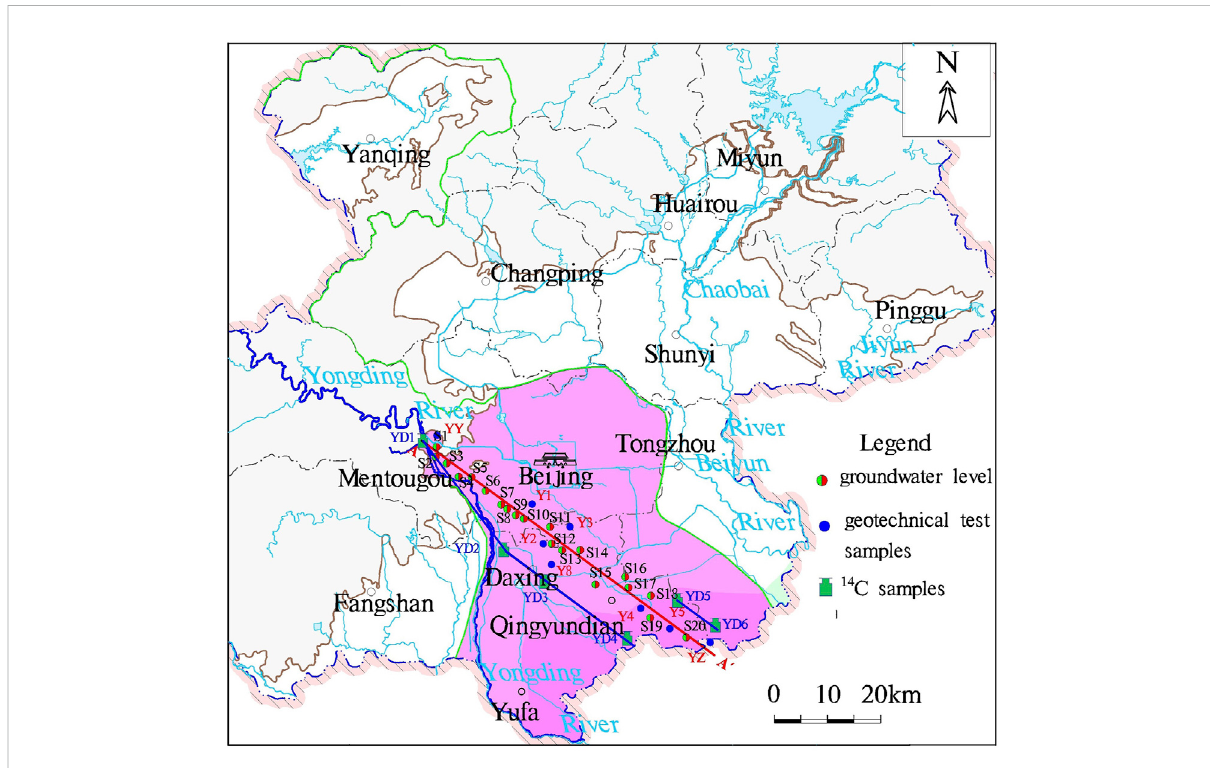
FIGURE 3 Location of the study area and the distribution of sampling